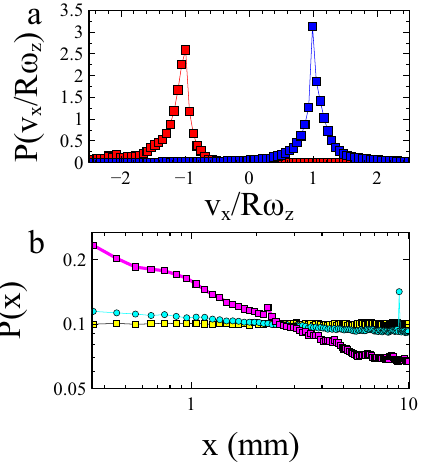
Figure 3. The effect of the wall. ( a ) Histograms of v x / R ω z for a simulated bouncing ball immediately after (red) or without (blue) a preceding collision with a wall. ( b ) Probability density plot as a function of the position in the cell on a log–log scale. The magenta plot shows the case of a rolling ball which undergoes an elastic collision with the cell walls. Both the remaining plots have zero tangential friction coefficient which stops the ball rotating. These simulations are done with an elastic (yellow) and inelastic (cyan) wall collision. Rolling results in a much larger density enhancement at the wall than inelasticity. The density profile shows a power law like dependence. (Figure prepared using Veusz https ://veusz .githu